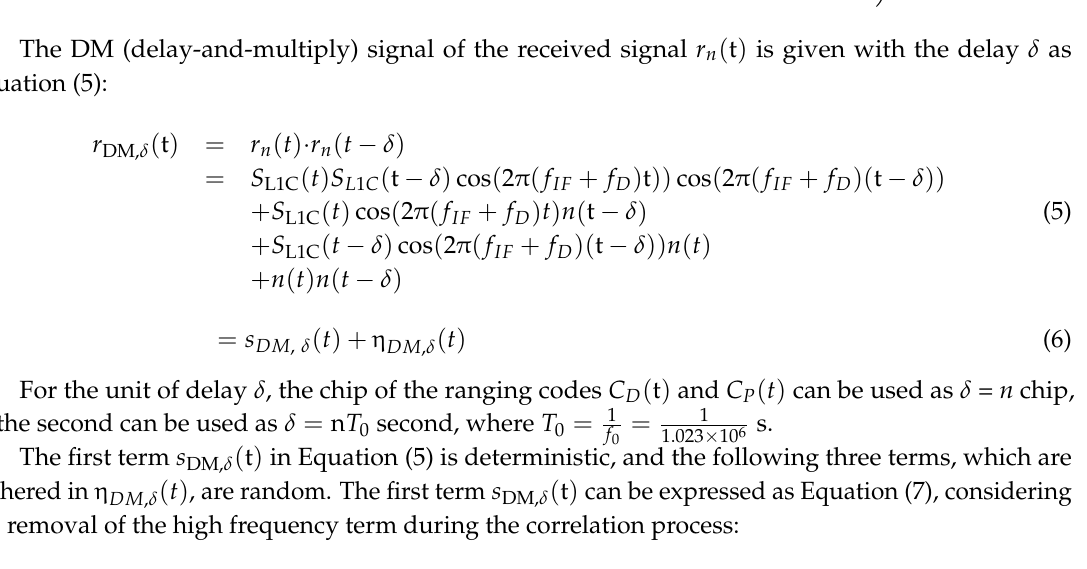
(cid:4672)(cid:2874),(cid:2869), (cid:3120) (cid:4673) Figure 3. Structure of TMBOC ( 6,1, 4 ) (cid:3119)(cid:3119) 33